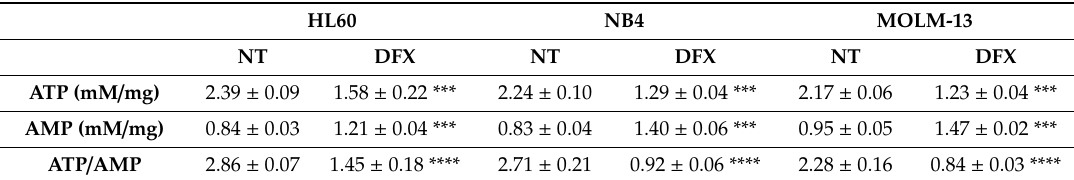
Table 2. Iron chelation induced a decrement of cellular energy status in acute myeloid leukemia cell lines. The table reports the intracellular level of ATP and AMP, and the consequent ATP / AMP ratio to investigate the cellular energy status. Data are expressed as mean + SD and are representative of three independent experiments. *** or **** indicate a p < 0.001 or p < 0.0001 respectively, between the same untreated or DFX-treated